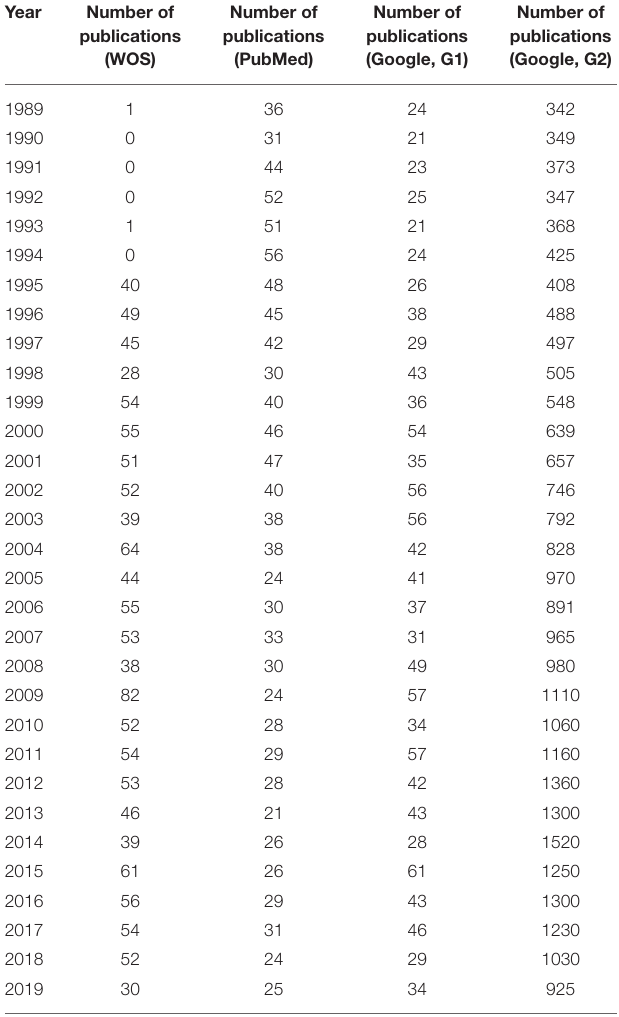
TABLE 1 | Number of publications of each year from 1989 to 2019 based on WOS, PubMed, and Google